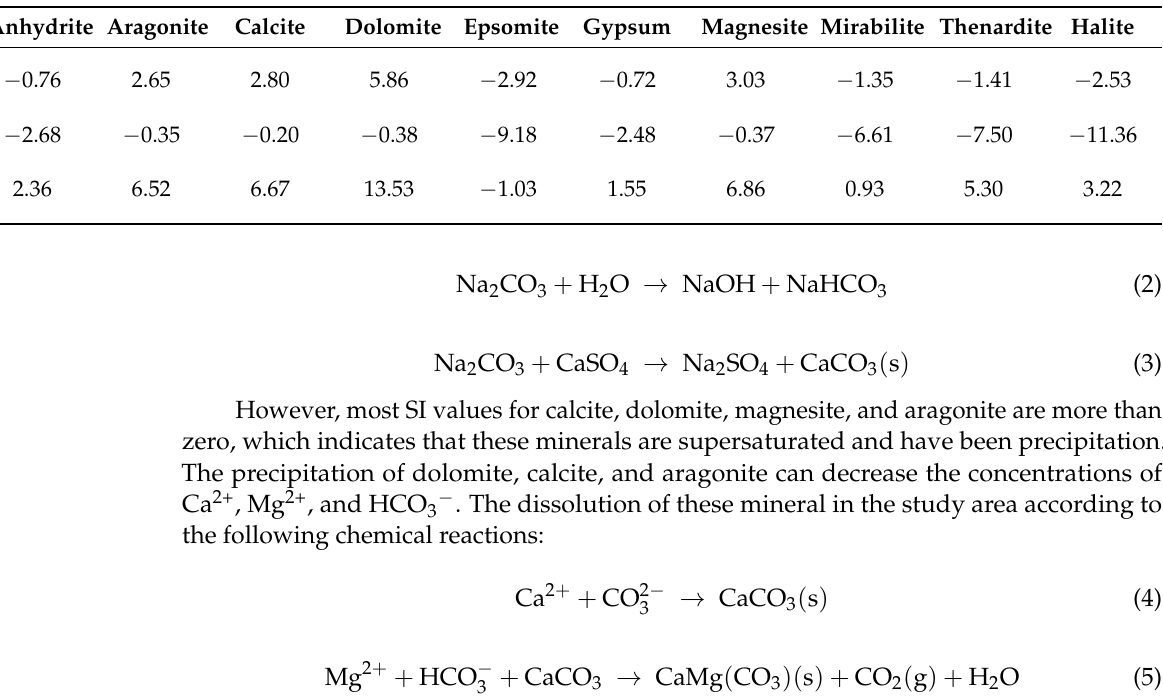
Table 2. Statistics of saturation index of main minerals in lakes